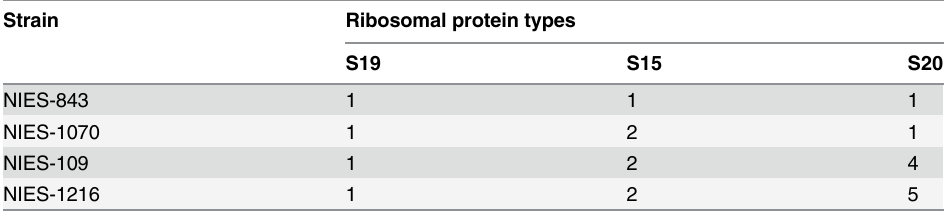
Table 3. Different S19, S15 and S20 ribosomal protein types for four